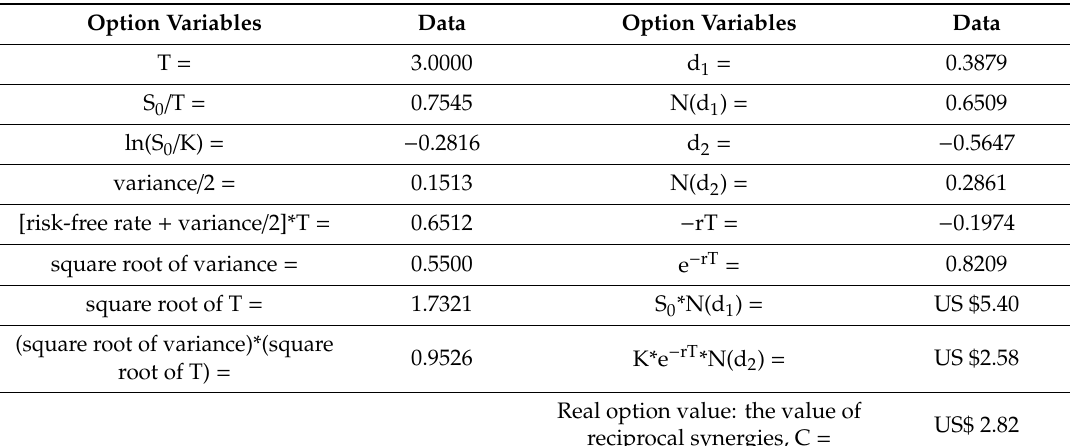
Table 10. Parameters of Black Scholes option pricing model and the value of reciprocal synergies: the European call option value (Natura’s acquisition of Avon Products Inc, in US$ bn).